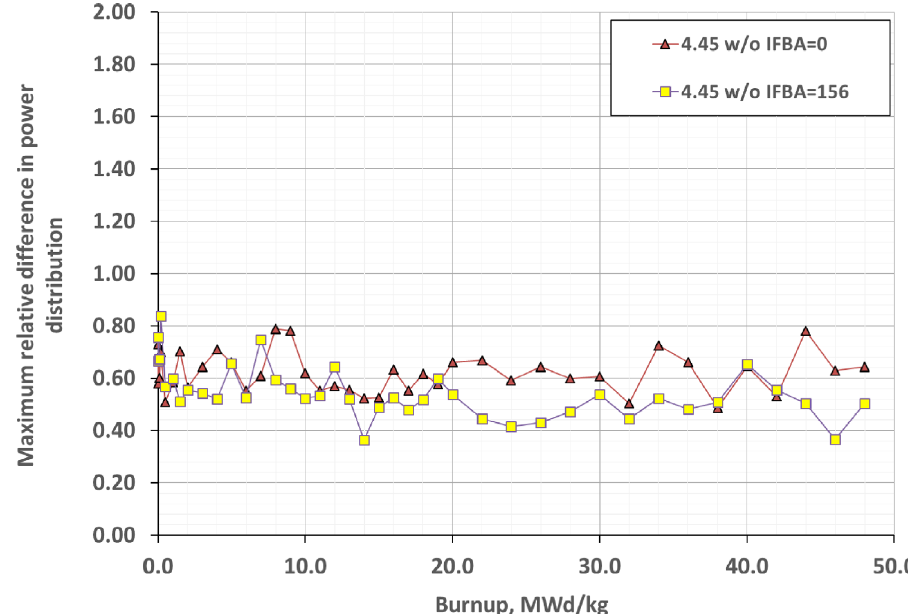
Fig. 6. Maximum relative difference (%) in assembly radial power distribution (WIMS vs. Serpent).